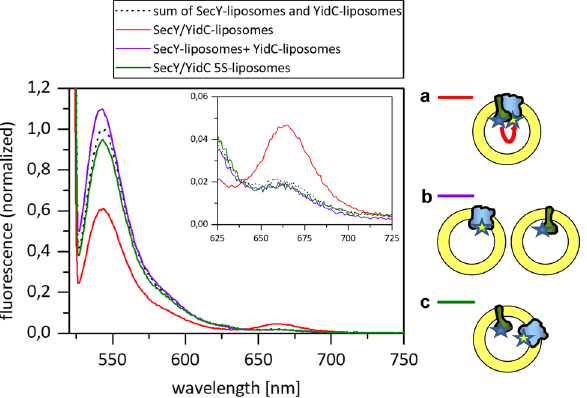
Figure 4. Fluorescence energy transfer (FRET) between YidC and SecYEG in proteoliposomes. Both YidC- Atto520 and SecYEG-Atto647N were reconstituted into proteoliposomes. ( a ) When both proteins were reconstituted simultaneously and were present in the same proteoliposome FRET was observed, resulting in a decrease of the donor fluorescence (red line) and increase of the acceptor fluorescence when compared with the sum of the fluorescence with the single proteins (black dotted line). ( b ) No FRET was observed when YidC and SecYEG were reconstituted into separate proteoliposomes and mixed (purple line). ( c ) As in a, but Atto520 labelled YidC-5S was combined with SecYEG-Atto647N in the same proteoliposomes (green line). The reconstitution of the proteins is shown in Fig.